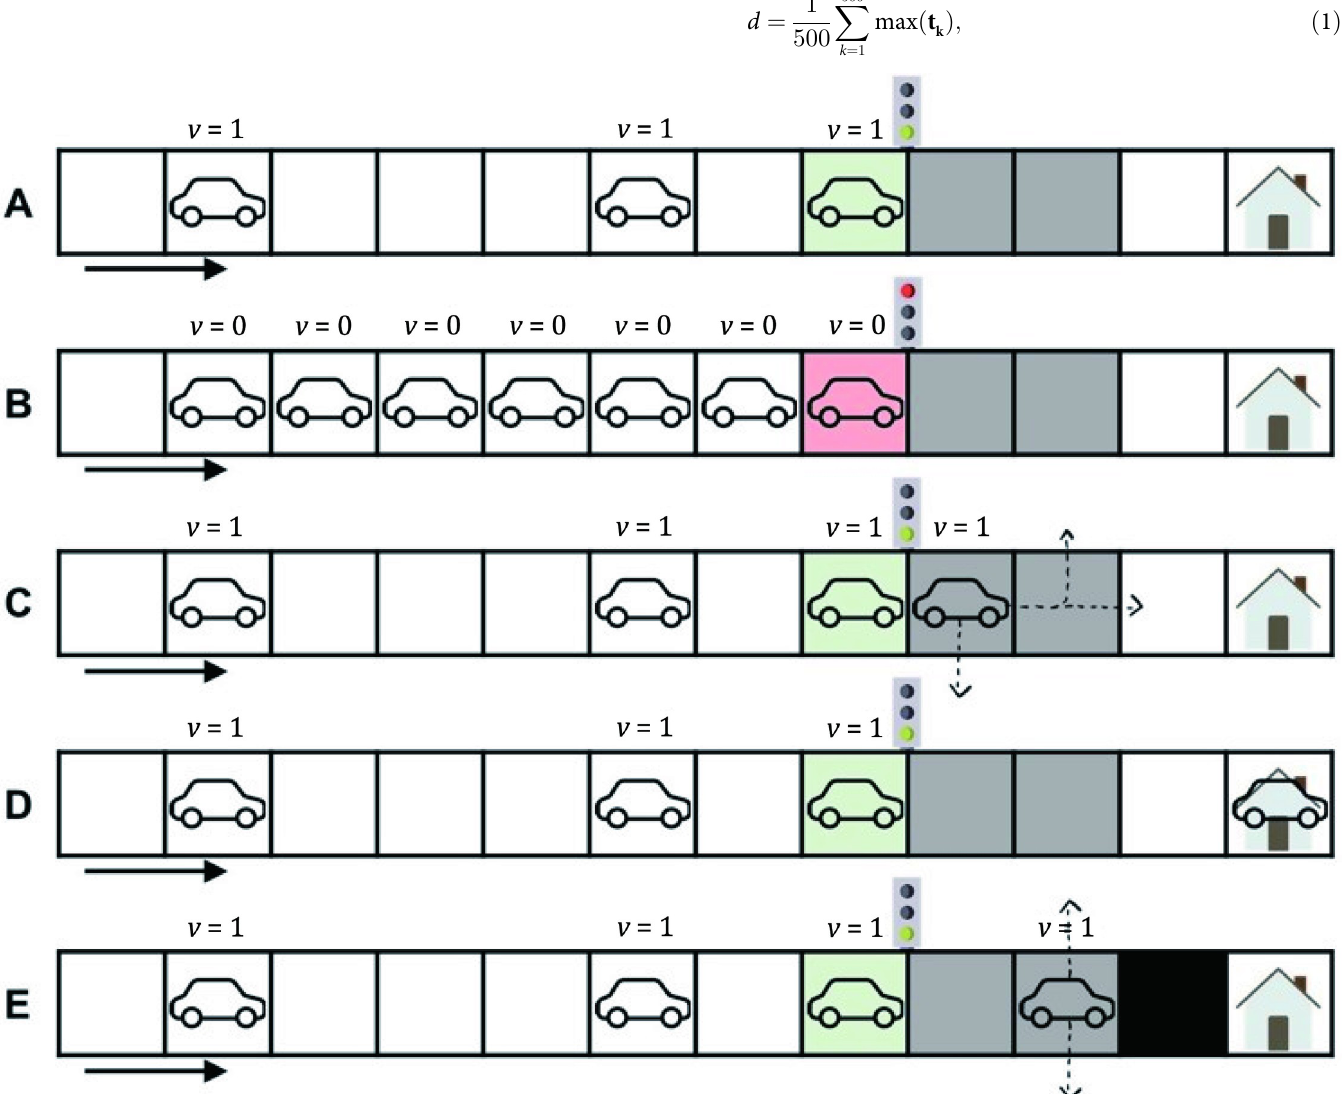
Fig 3. Five cases of simplified car movement at two speeds: Zero and one. The green, yellow, or red areas represent traffic lights. The white areas are roads, and the gray areas are intersections. When a car arrives at a shelter, the evacuation process is completed.